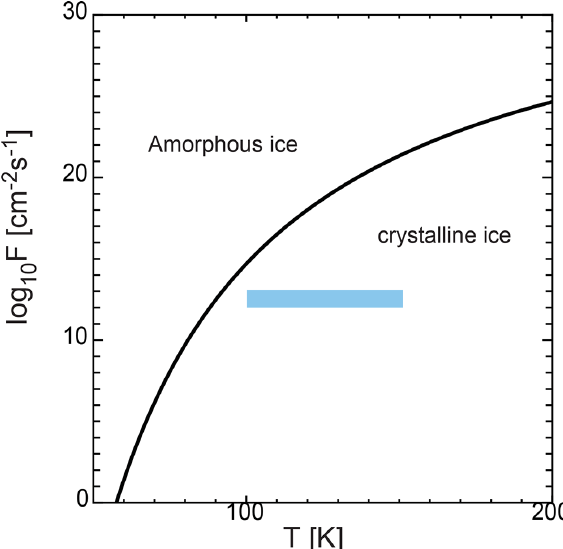
Figure 8. Flux of water molecules given by F c and shown by the solid line. In the region larger than F c , the solid ice is considered to be amorphous, while in the smaller region it is crystalline. In the mesosphere, the flux of water molecules F is approximately 10 12 – 10 13 cm − 2 s − 1 for the temperature range of 100–150K (shaded re-